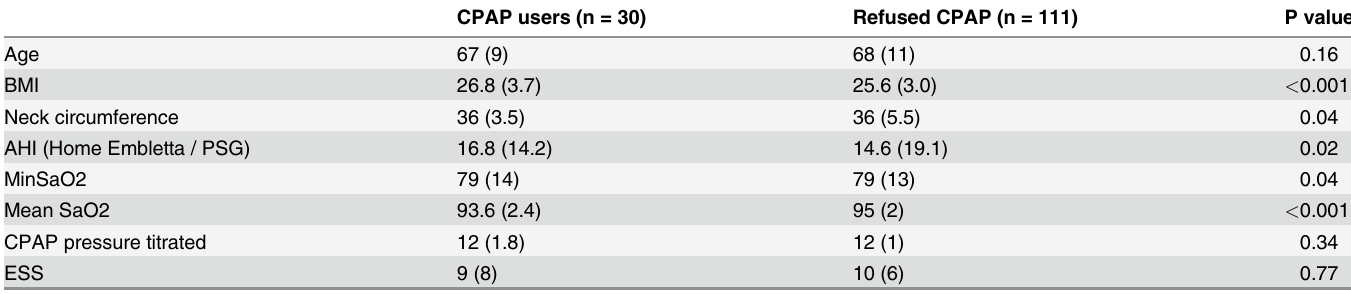
Table 7. Comparisons between subjects who accepted and those who refused home CPAP treatment with variables expressed as median (IQR).